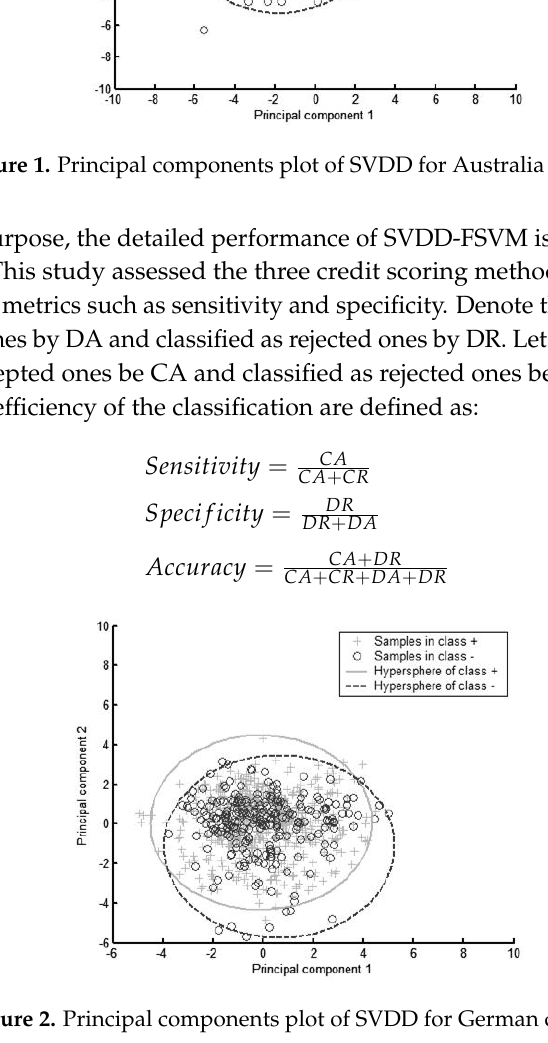
Table 2. Performance on the Australian test data set.